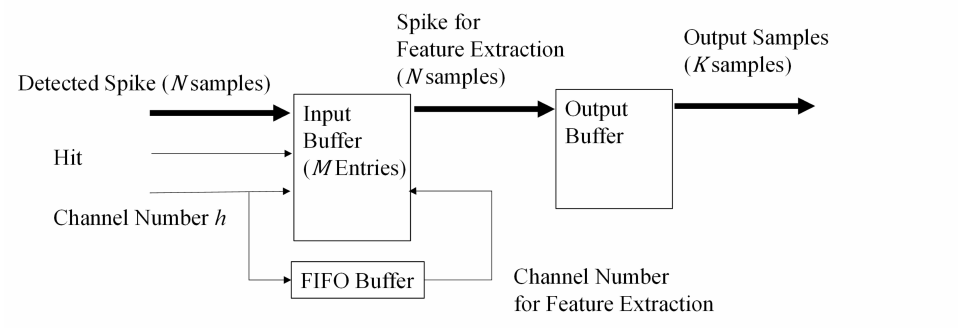
Figure 15. The architecture of the spike